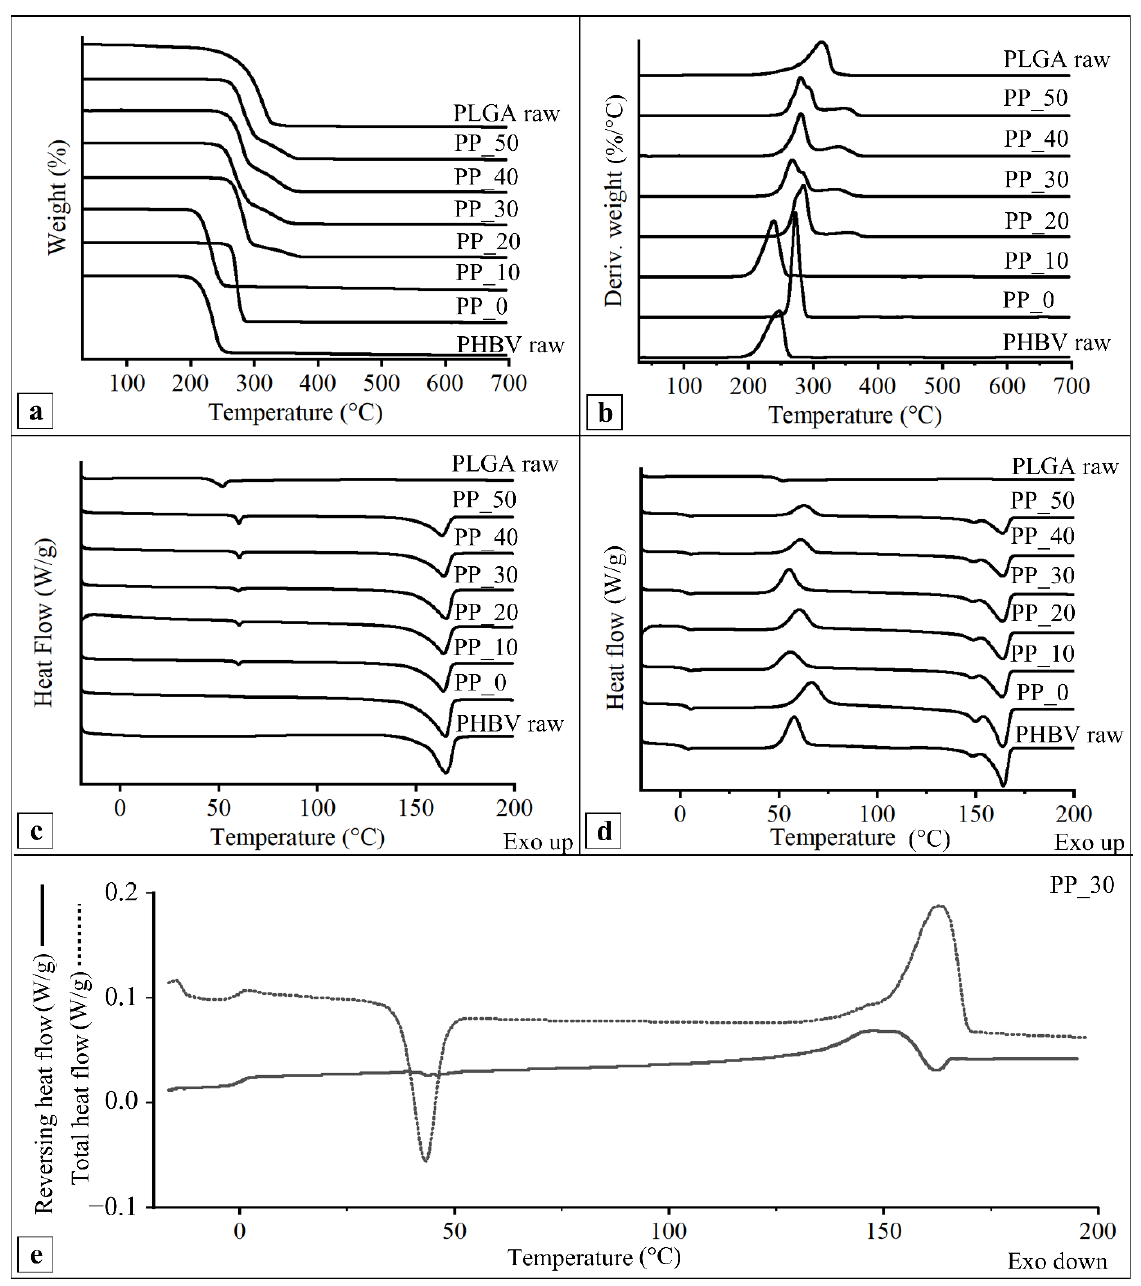
Figure 5. Representative thermograms of raw polymers (raw PHBV and raw PLGA) and scaffolds with different PHBV/PLGA weight ratios (PP_0, PP_10, PP_20, PP_30, PP_40, and PP_50) obtained by Thermogravimetric Analysis (TGA), reported as ( a ) weight loss vs. temperature and ( b ) derivative of weight vs. temperature curves, and by Differential Scanning Calorimetry (DSC), reported as ( c ) first heating scan and ( d ) second heating scan curves; ( e ) representative thermogram obtained by means of modulated DSC analysis and relevant to the second heating scan of the PP_30 scaffold.